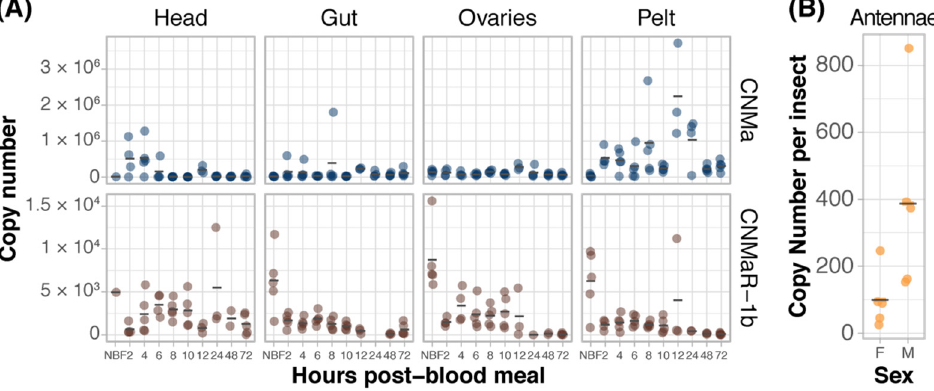
Figure 3. Expression patterns of AeCNMa receptors and peptide. ( A ) qPCR was used to measure AeCNMaR-1a (yellow), AeCNMaR-1b (red), and AeCNMa (blue) expression in tissues dissected from adult females at various times post-blood meal. Expression of AeCNMaR-1b was highest in ovaries prior to a blood meal (NBF), decreasing steadily until 12 h PBM. Expression of the receptor was also high in other tissues prior to a blood meal, and there was moderate expression in female heads 4–10 h PBM. AeCNMa was most highly expressed in female pelts 2–24 h post blood meal, peaking at 12 h PBM, with secondary expression in the head at 2–4 h PBM. ( B ) AeCNMaR-1a expression was only detected in male antennae. For all plots, points represent individual expression values and bars represent mean.